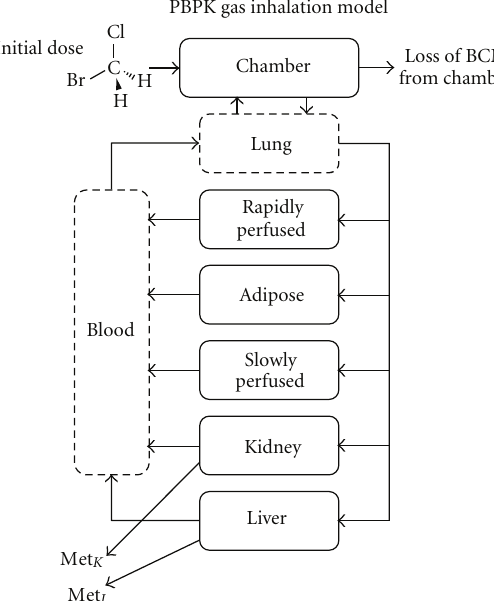
Figure 3: Schematic representation of PBPK model used for BCM.